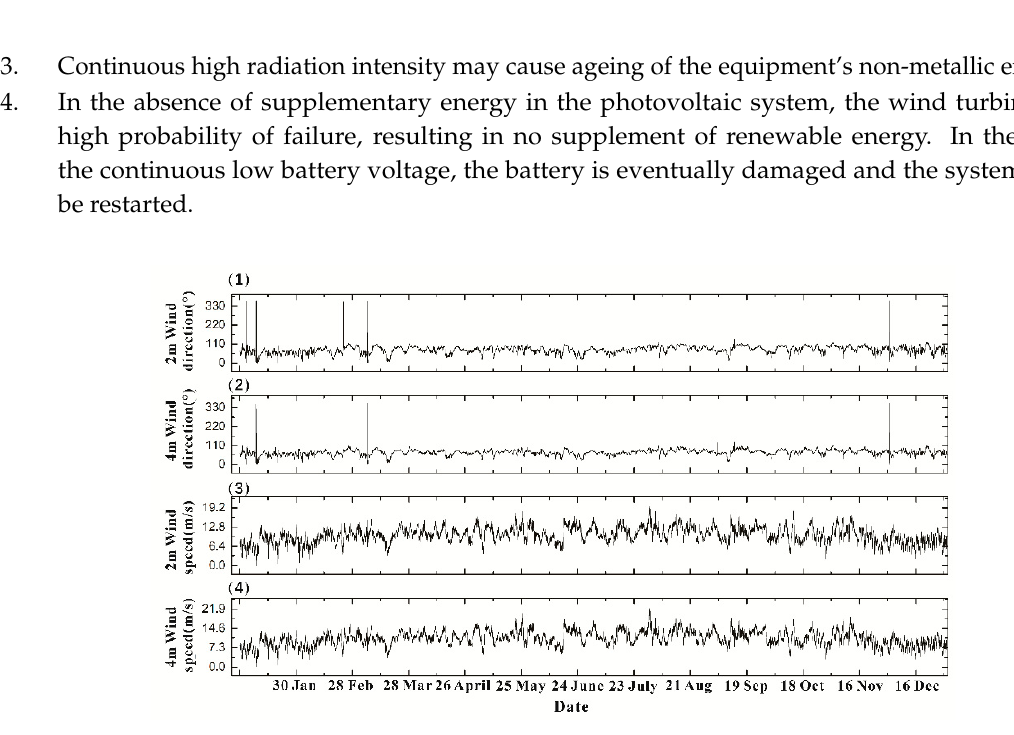
Figure 5. (1) 2m wind direction, (2) 4m wind direction, (3) 2m wind speed, and (4) 4m wind speed. Wind speed and wind direction data of meteorological tower at Tai-Shan station of Chinese Academy of Meteorological Sciences in